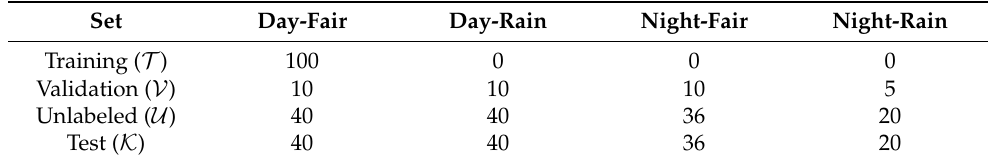
Table 2. Number of sequences assigned to training, validation, unlabelled, and test subsets for each dataset split S i according to the four main categories considered in this